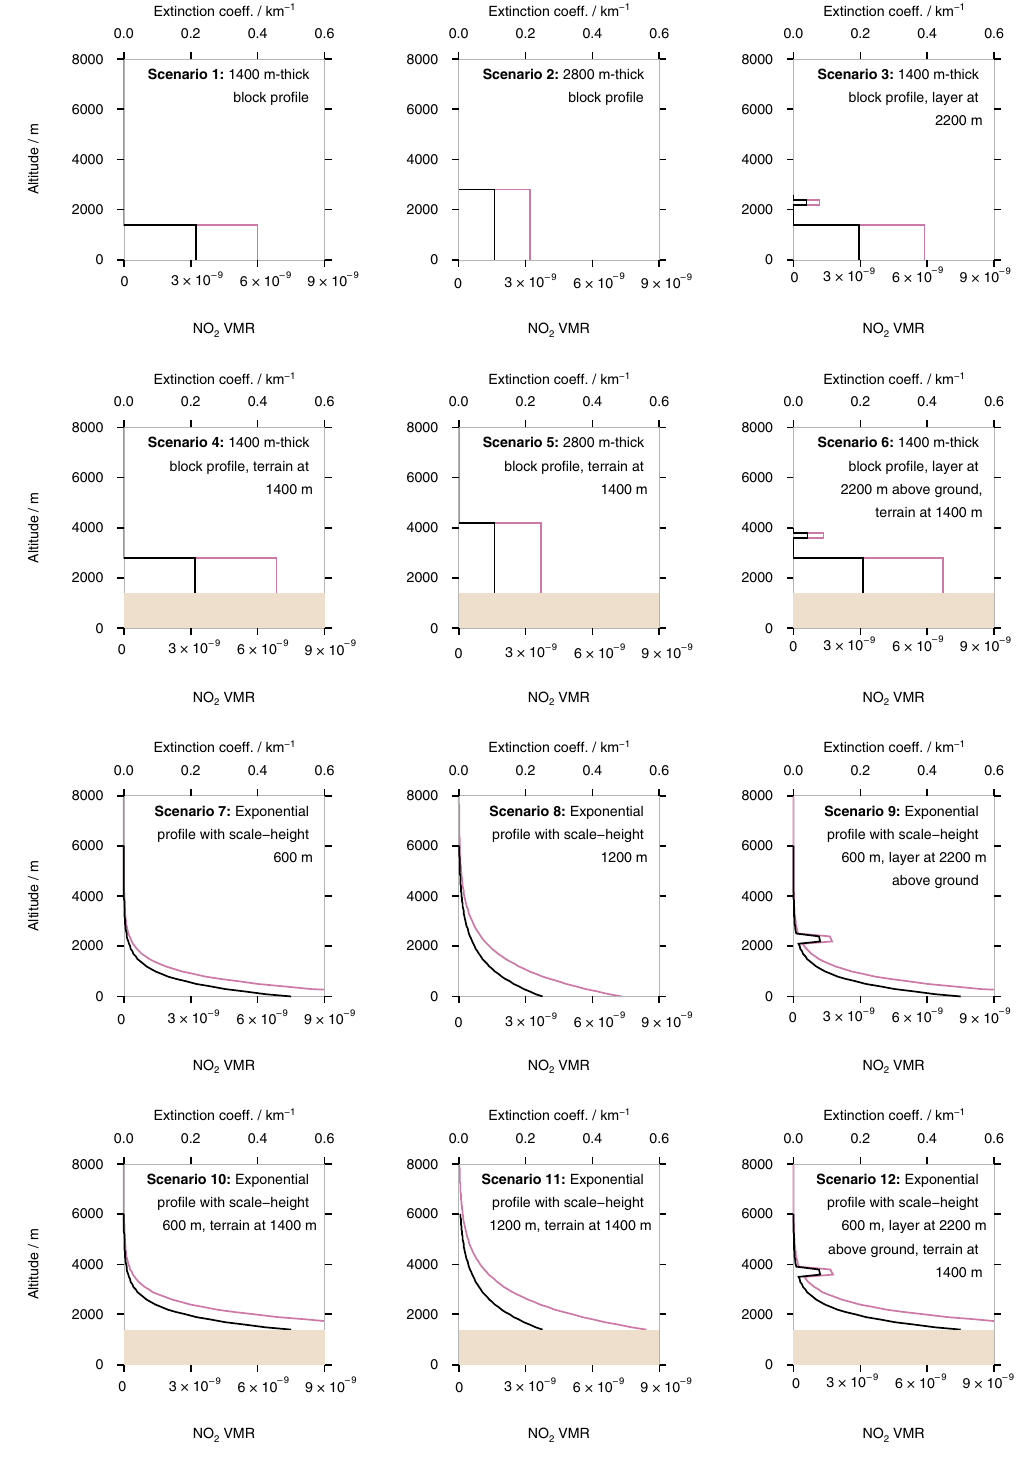
Figure 4. Profile shapes of aerosol extinction coefficient (black line) and NO 2 mixing ratio (purple line) for the 12 scenarios used in the radiative transfer model sensitivity study. The scenarios are designed to all have the same NO 2 VCD. Extinction and absorption coefficients are scaled to produce aerosol optical thicknesses of 0.1, 0.3, and 0.5. Terrain height is indicated by the shaded light brown area. Note that the vertical grid used in the model extends up to